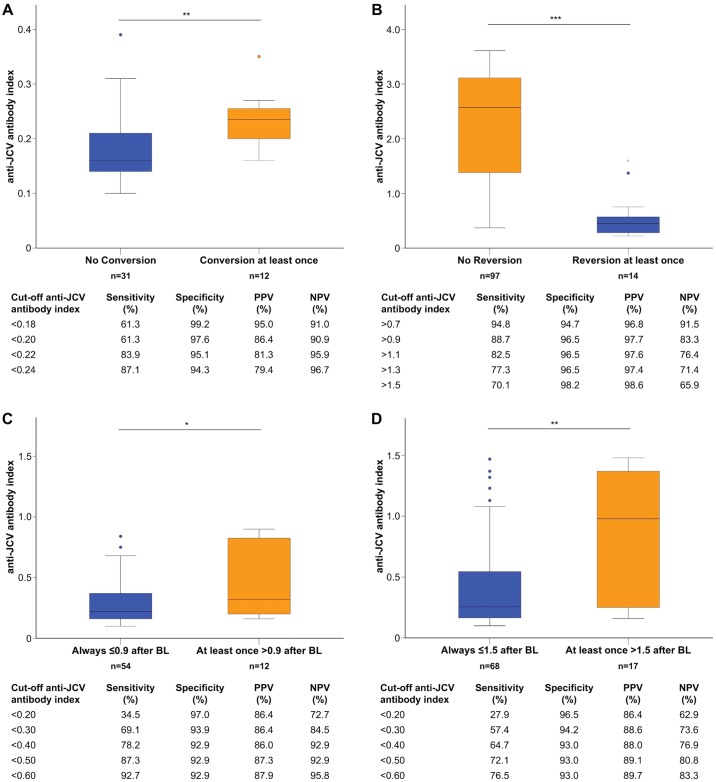
Predictive value of baseline anti-JCV antibody index.(A) Anti-JCV antibody index in seronegative patients at baseline according to seroconversion status at follow-up. Predictive value of different anti-JCV antibody index levels at baseline for prediction of stable seronegative status at follow-up (AUC: 0.986, p<10−23). (B) Anti-JCV antibody index in seropositive patients at baseline according to seroreversion status at follow-up. Predictive value of different anti-JCV antibody index levels at baseline for prediction of stable seropositive status at follow-up (AUC: 0.976, p<10−15). (C) Anti-JCV antibody index in patients with baseline values ≤0.9 according to the change to a higher index category (>0.9) at follow-up. Predictive value of different anti-JCV antibody index levels at baseline for prediction of stable JCV index ≤0.9 at follow-up (AUC: 0.962, p<10−20). (D) Anti-JCV antibody index in patients with baseline values ≤1.5 according to the change to a higher index category (>1.5) at follow-up. Predictive value of different anti-JCV antibody index levels at baseline for prediction of stable JCV index ≤1.5 at follow-up (AUC: 0.948, p<10−20). Ab, antibody; AUC, area under the curve; BL, baseline; JCV, John Cunningham virus; NPV, negative predictive value; PPV, positive predictive value; ROC, receiver operating characteristic; **, *** indicate statistical significance at a P-value <0.01 and <0.001, respectively.